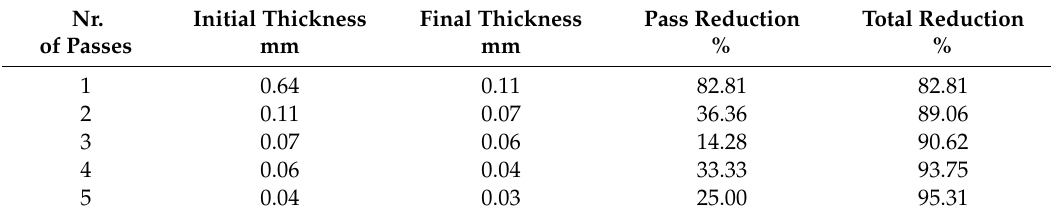
Table 5. Cold rolling deformation parameters for nanostructured